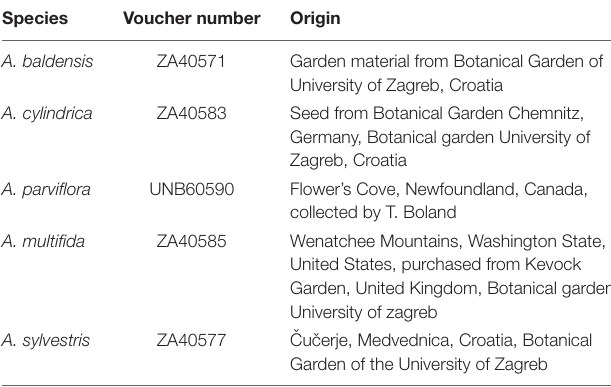
TABLE 1 | List of Anemone species studied, their voucher number, origin and colection data.